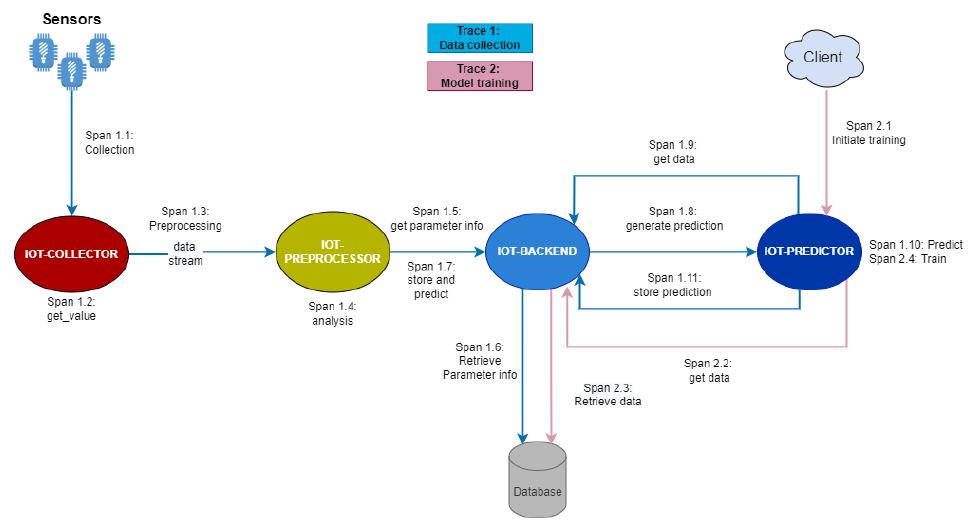
Figure 6. Distributed IoT application graph.